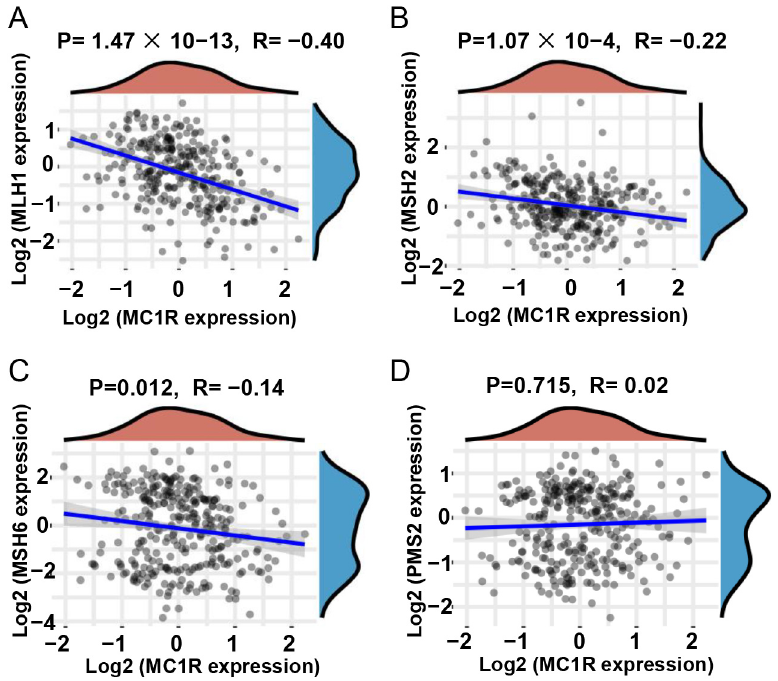
Figure 4. Correlation between MC1R expression and MMR genes expression. ( A ) MLH1 , ( B ) MSH2 , ( C ) MSH6 , and ( D ) PMS2 relative to MC1R